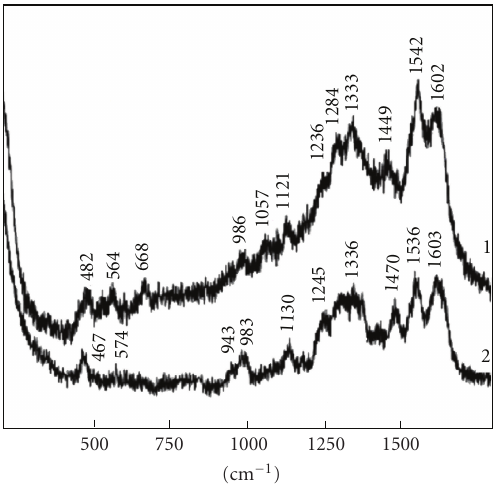
Figure 7: The SERS spectra ( λ exc = 514 . 5 nm) of compound 5a adsorbed on the annealed (1) and unannealed (2) silver